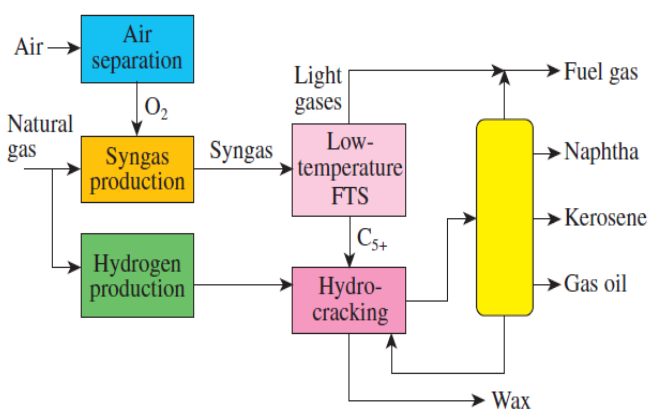
Figure 5. Schematic of CO simplified schematic of Shell gas-to-liquid (GTL) plant. Reproduced with permission [124].